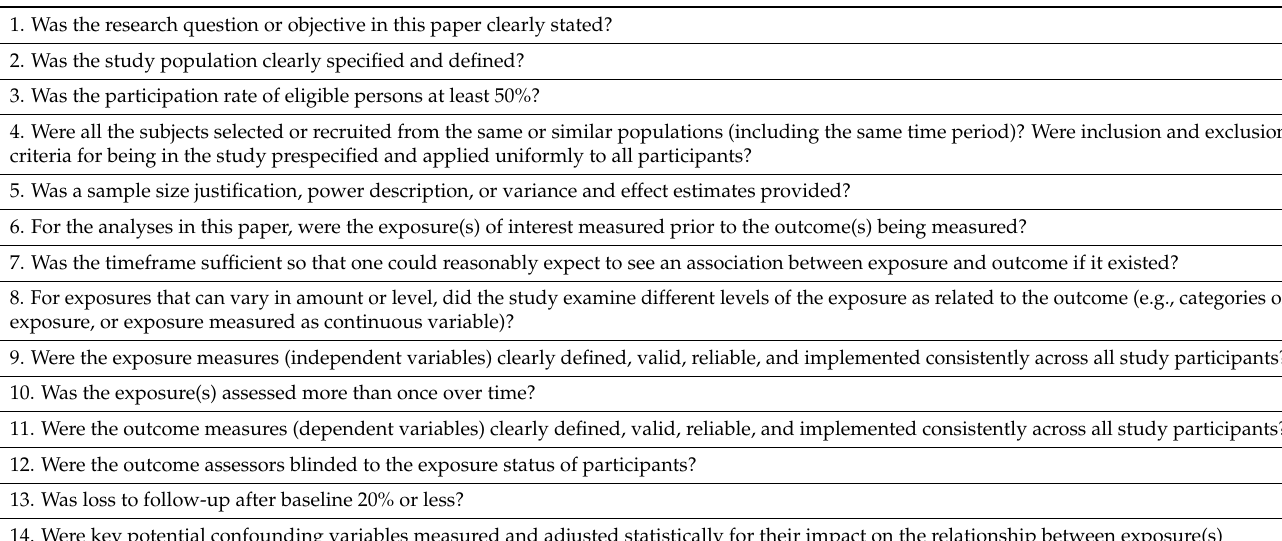
Table A1. Quality Assessment Criteria for Observational Cohort and Cross-Sectional